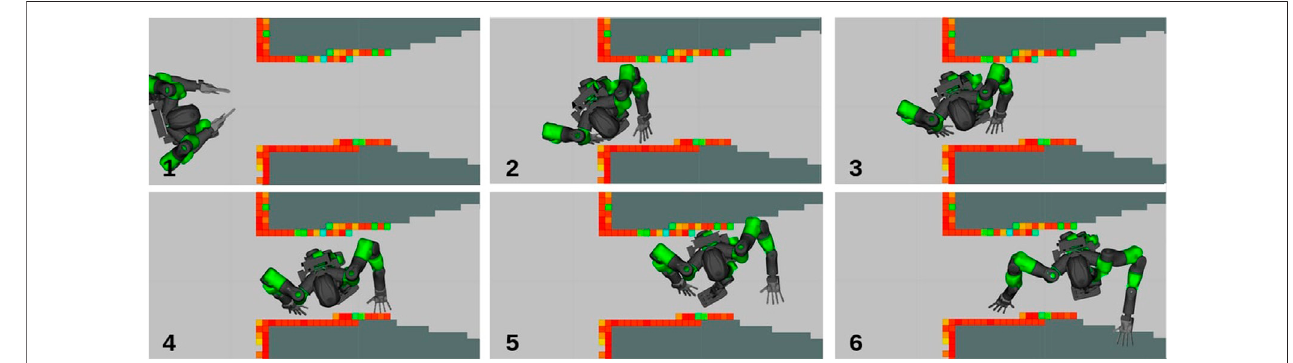
FIGURE 8 | Screenshots of COMAN+ passing through the high narrow corridor.